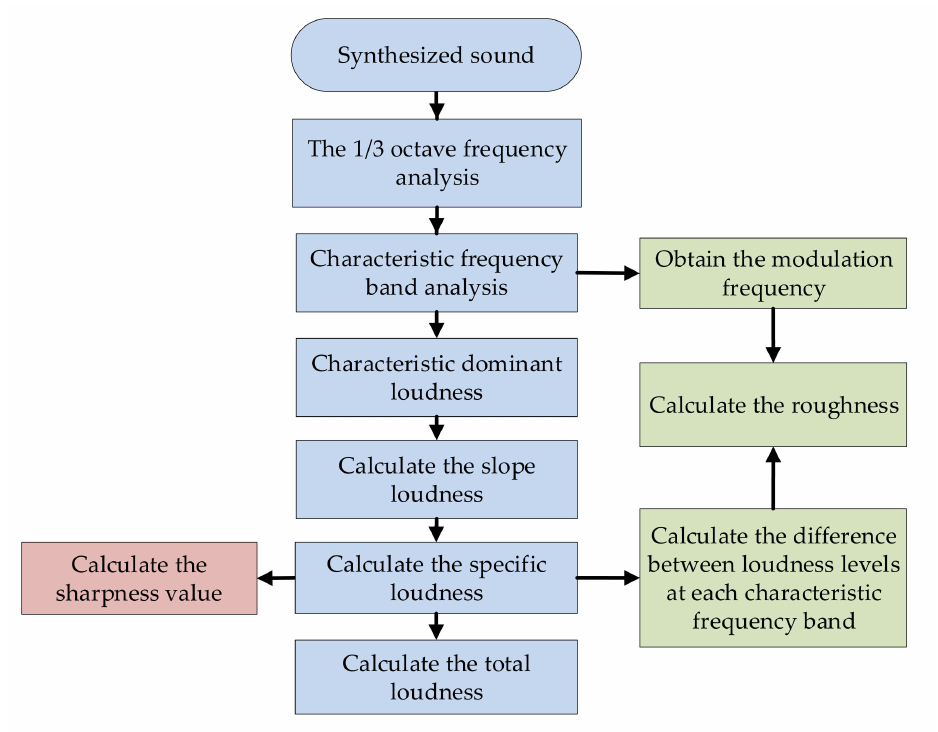
Figure 3. Flowchart for calculating the objective psychoacoustic evaluation parameters of